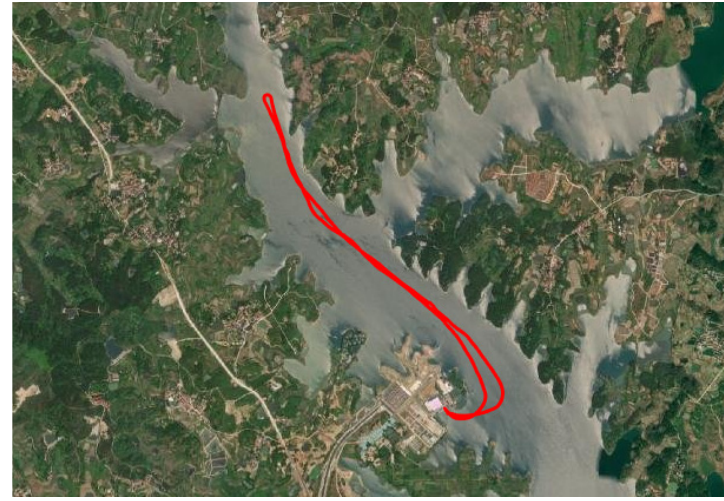
Figure 22. Navigation trajectory.